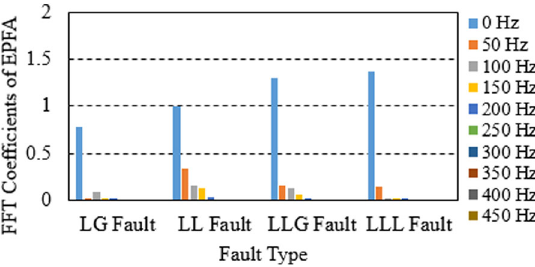
Fig. 6 FFT spectra of EPFA variation with fault conditions of